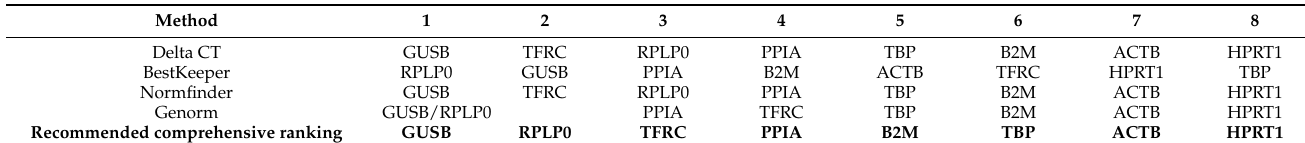
Table 2. Ranking order of eight reference genes tested for qRT-PCR studies in FaDu cells. FaDu cultures treated with C (control), NP-Ø (unloaded NPs, 0.5 and 0.75 mg/mL), and NP-PHT427 (PHT427-loaded NPs, 0.5 and 0.75 mg/mL) for 24 h.